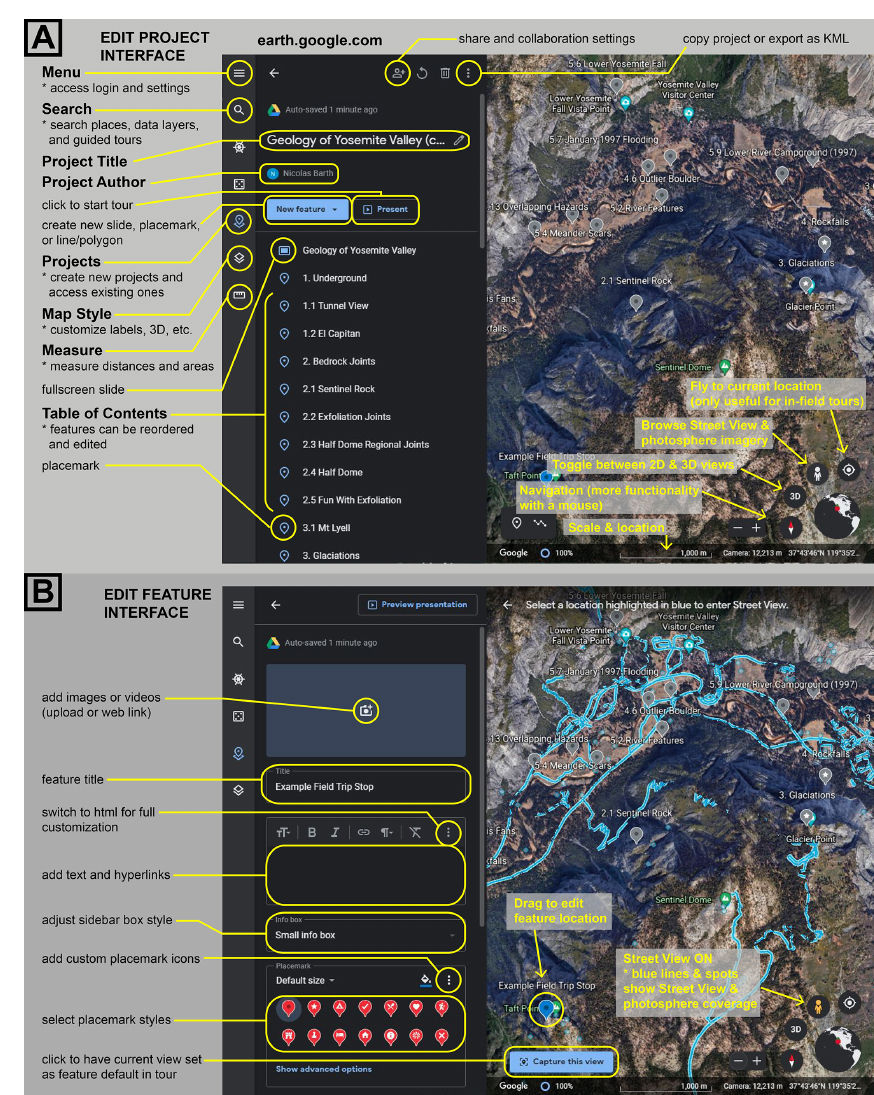
Figure 2. Creating a VFT Earth project in © Google Earth Web. (a) A view highlighting the interface for editing a project (i.e., VFT). All changes are instantly saved to the cloud (the creator’s Google Drive). (b) A view highlighting the interface for editing a feature (i.e., virtual field trip stop). Many customizable options